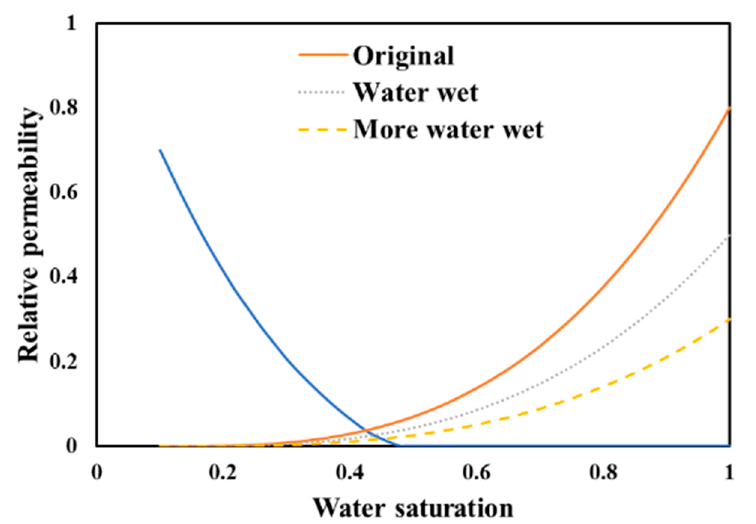
Figure 7. Original and two other water-wet oil–water relative permeability curves, with the crossing points changing from 0.43 to 0.45. The blue line is the oil relative permeability curve.